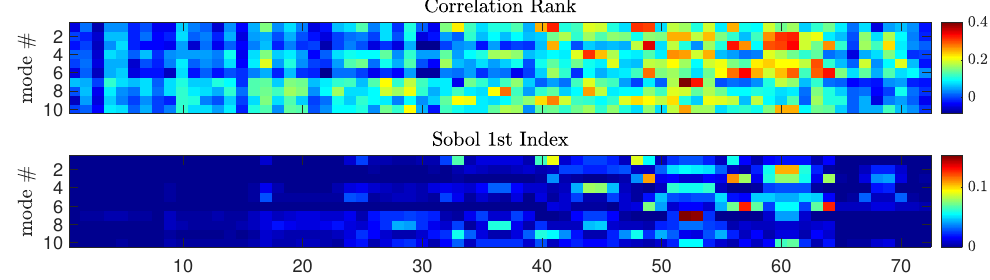
Figure 7. Dam-1; comparison of sensitivity indices for two methods and 10